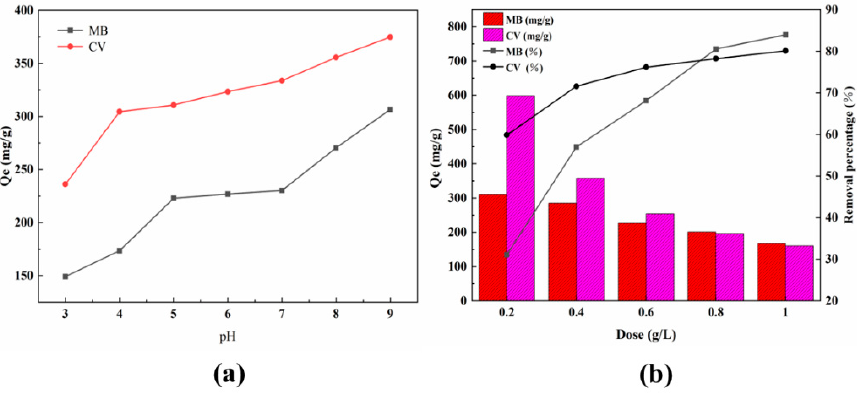
Figure 3. The effect of ( a ) pH and ( b ) biosorbent dosage on MT adsorption capacity.